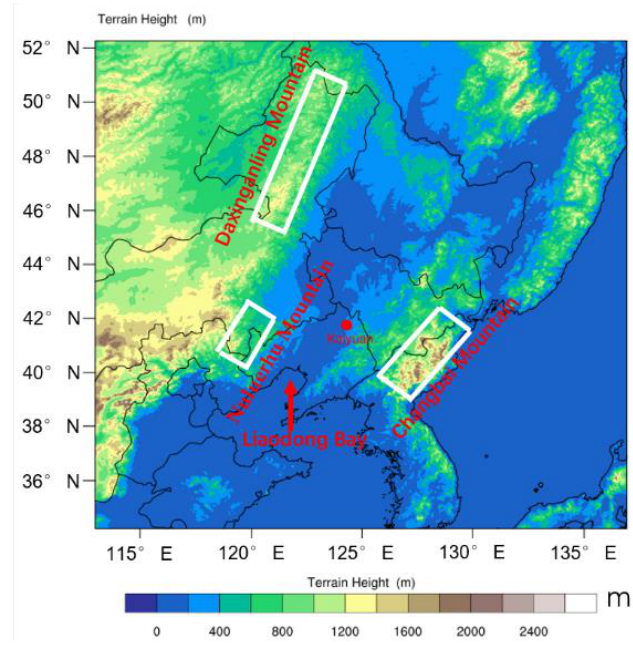
Figure 6. The terrain height (shaded; m) of Northeast China.